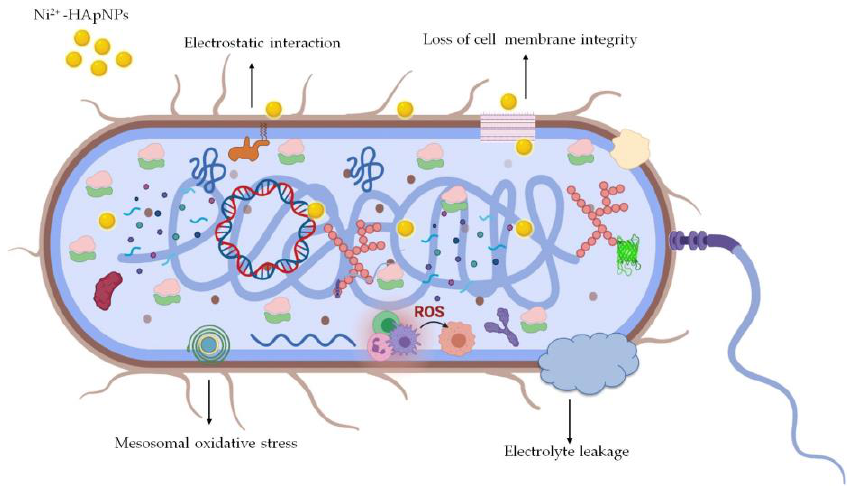
Figure 8. Illustration of the possible mechanism by which Ni 2+ -doped HApNPs exert their antibacterial effects.